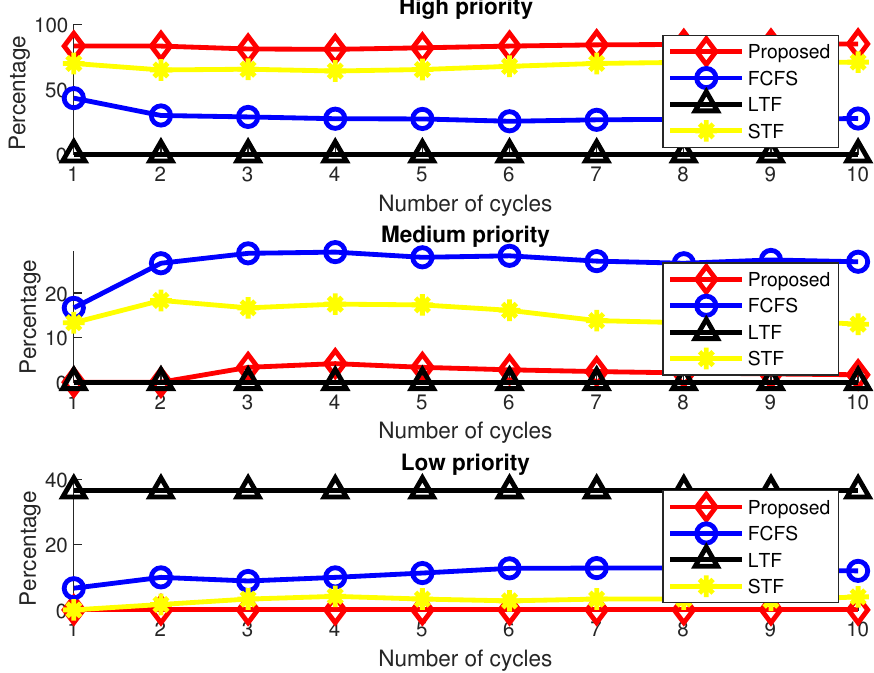
Figure 4. Percentage of tasks performed by fog nodes in different processing